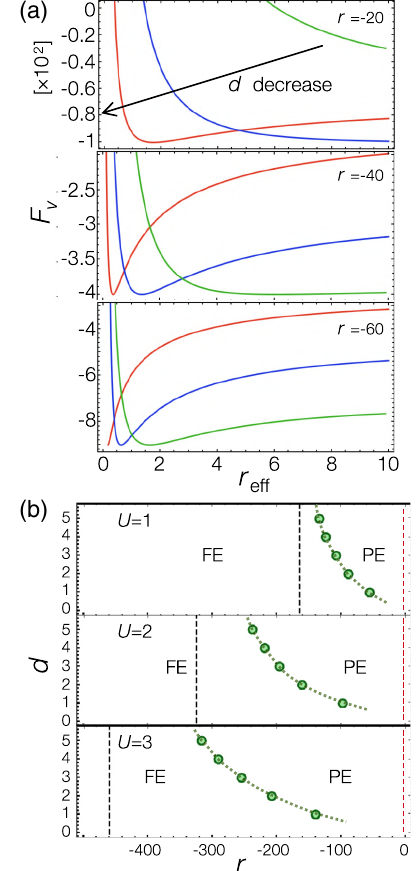
FIG. 8. (a) Variational free energies F plotted against the v variational parameter r with decreasing tuning parameter r eff from top to bottom. The red and blue solid curves correspond to the results for the cavity setting with the insulator thicknesses d ¼ 1 and d ¼ 3 , respectively, while the green solid curves correspond to the bulk results. The minima of the variational energies determine the equilibrium values r (cid:2) of the ¼ Ω 2 eff eff effective phonon frequency including the nonlinear feedback. (b) Phase diagram in the cavity setting at different nonlinear strengths U . As the tuning parameter r is decreased, the transition from the paraelectric phase (PE) to the ferroelectric phase (FE) occurs when the equilibrium effective phonon frequency r (cid:2) goes eff down to zero. The green dashed curve is the phase boundary in the cavity geometry, while the black (respectively, red) vertical dashed line is that in the bulk geometry (respectively, at U ¼ 0 ). 5 , g ¼ 3 . 5 , and the momentum We set c ¼ ℏ ¼ β ¼ 1 , ω p ¼ 10 2 cutoff to be Λ c ¼